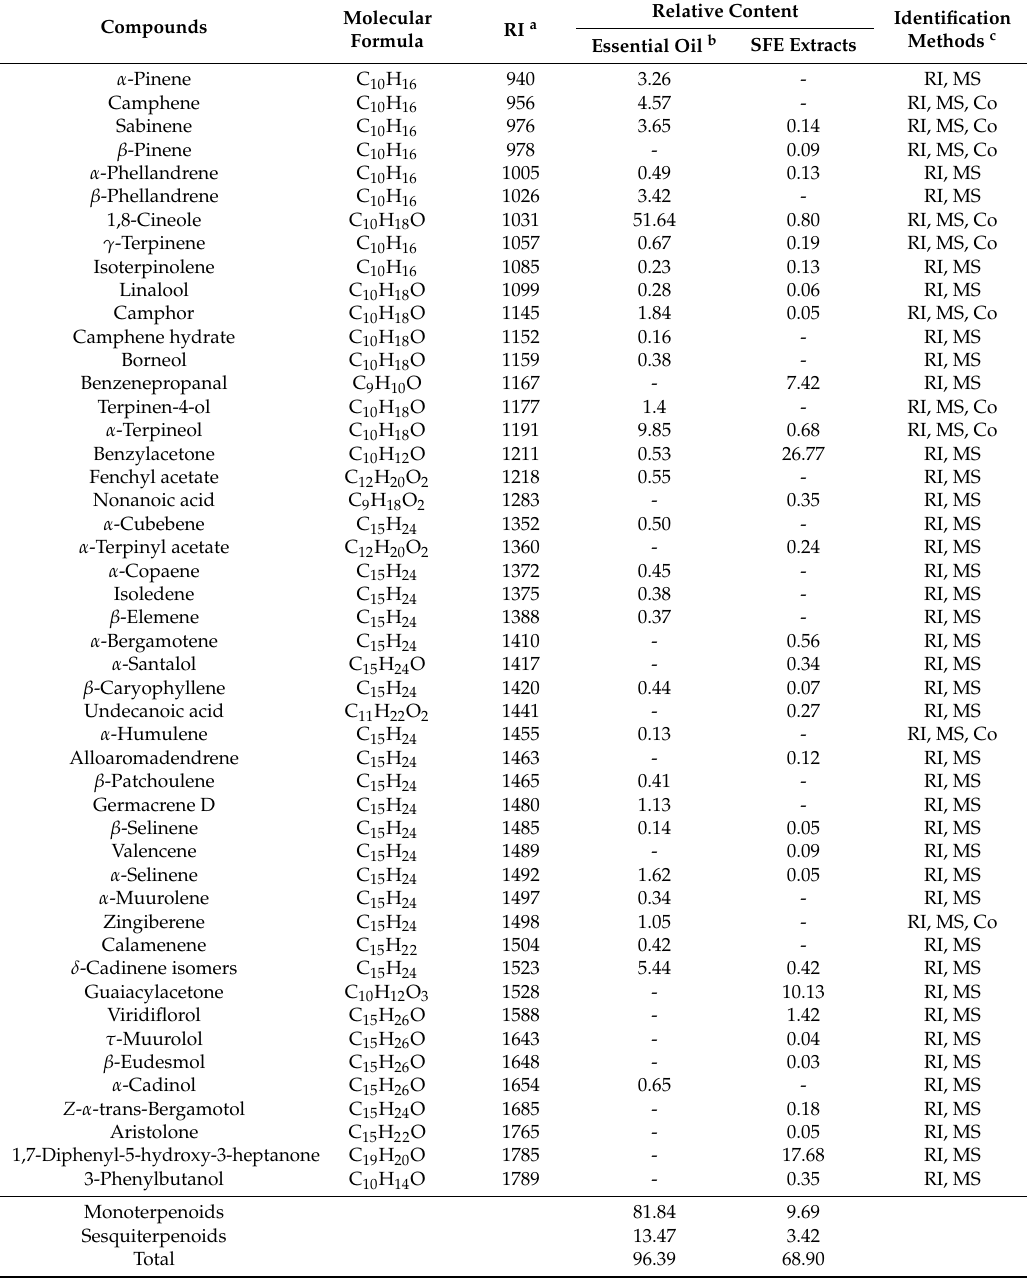
Table 1. Chemical components of two samples from A. officinarum rhizomes. Relative Compounds Molecular RI a Formula